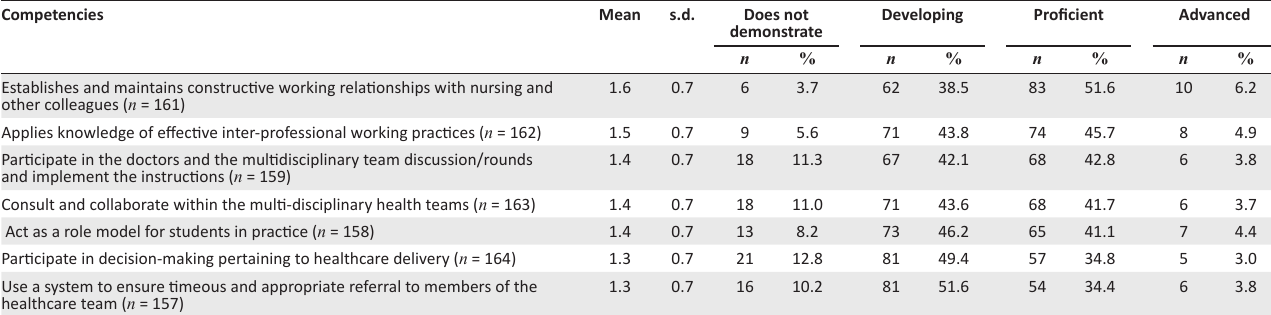
TABLE 2: Competence ratings for interprofessional practice domain. Competencies